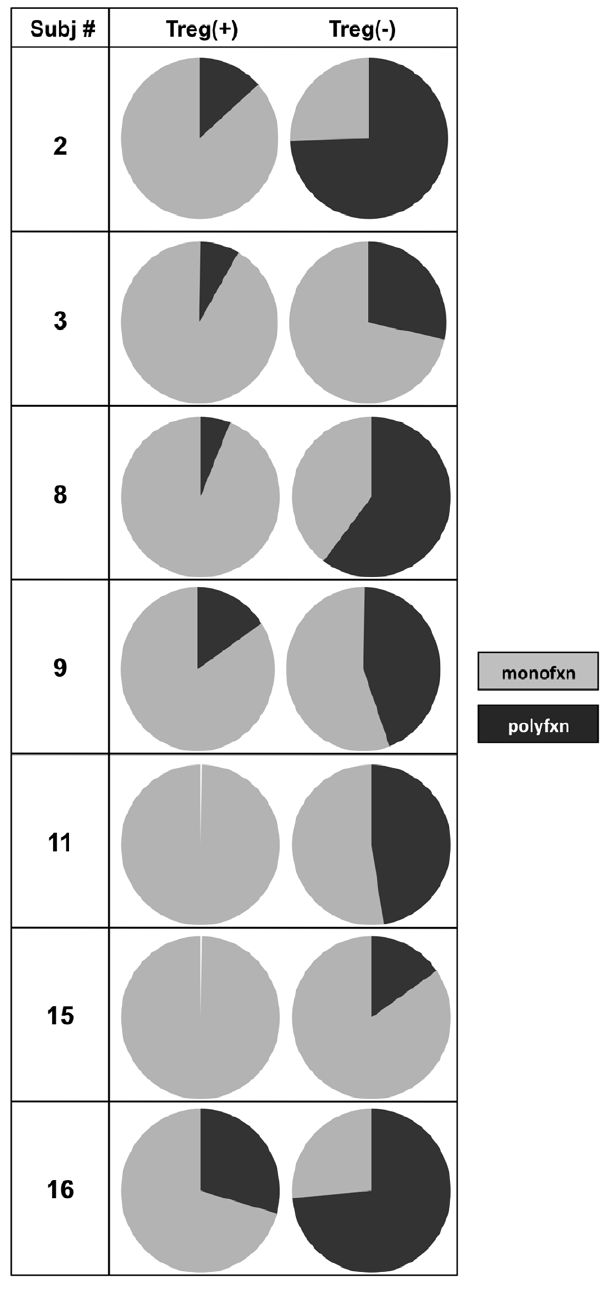
Figure 7. Proportion of monofunctional (monofxn) and poly- functional (polyfxn) CD8 + T cells in 7 HIV-1 subjects. The polyfunctional vaccine response to Gag peptide in each of the 7 HIV-1- infected subjects is shown before [Treg( + )] and after [Treg( 2 )] Treg depletion.